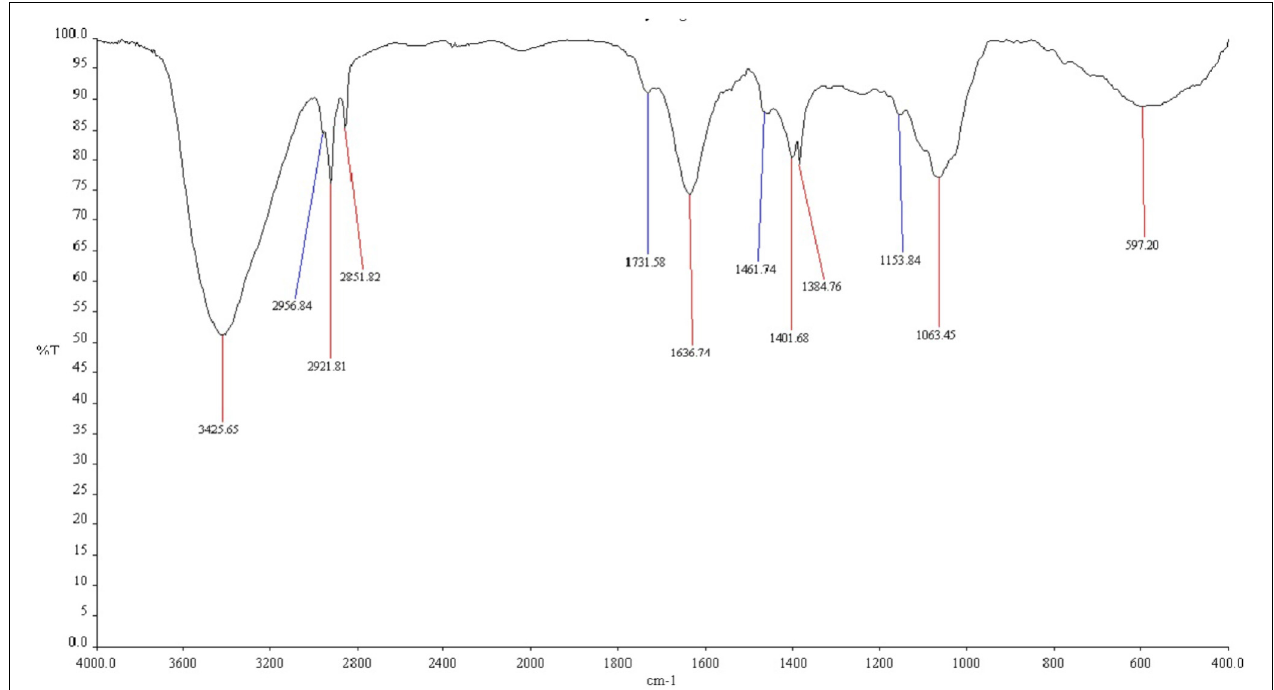
FIGURE 7 | Fourier Transform Infrared spectra of bio-surfactant isolated from